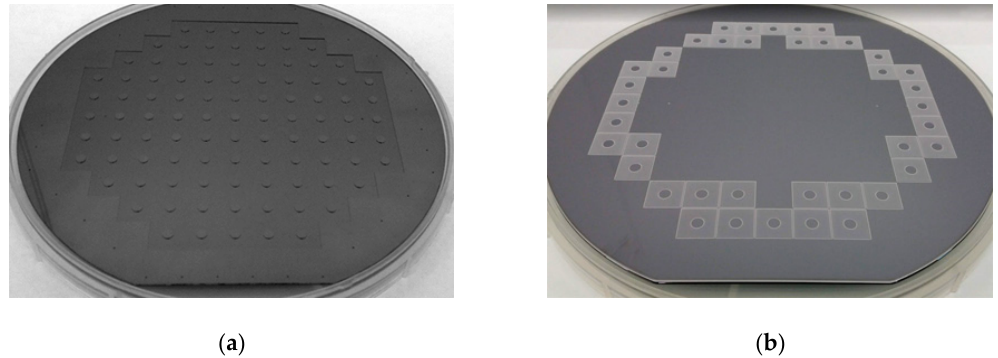
Figure 12. Pillars formed on rear of wafer: ( a ) Type I-A and ( b ) Type II-A.